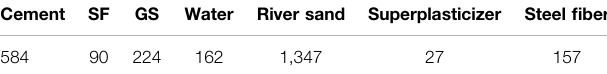
TABLE 3 | Mix proportions of RPC/Kg · m-3.